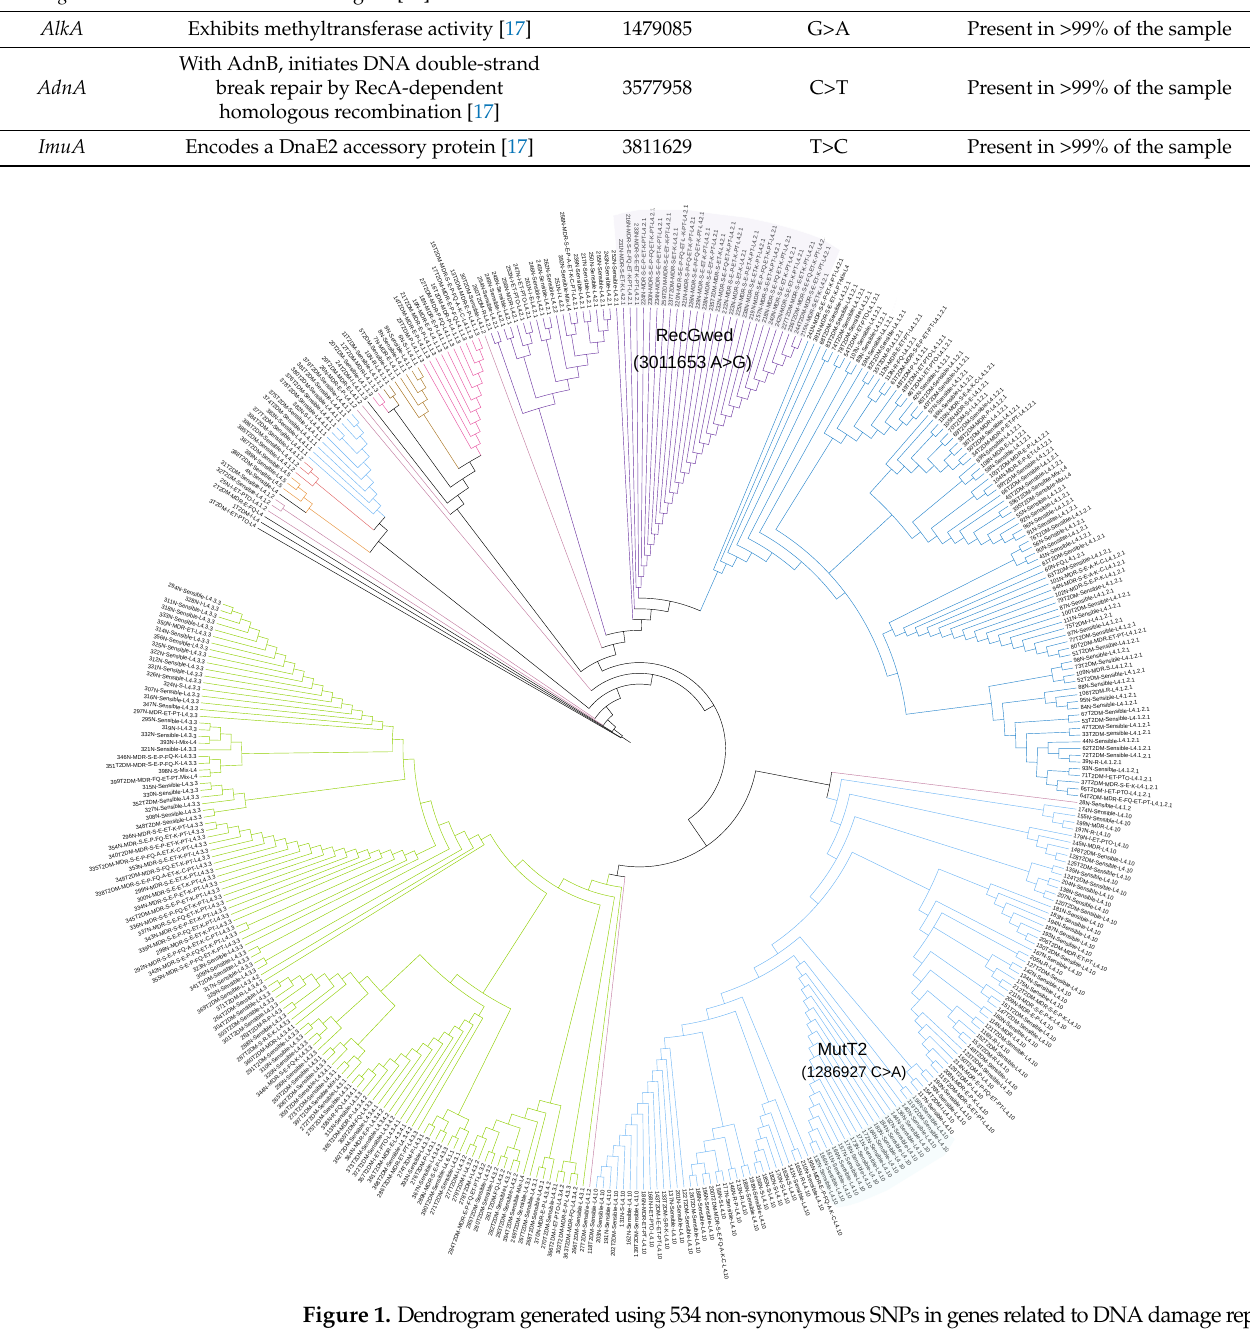
Figure 1. Dendrogram generated using 534 non-synonymous SNPs in genes related to DNA damage repair. Given this observation, both sub-lineage-fixed SNPs and redundant SNPs in the sample were given no further consideration in the comparative analysis between host groups or resistance profiles. It should be noted that 11.7% of the genomes ( n = 47) did not present non-synonymous SNPs, other than those related to the